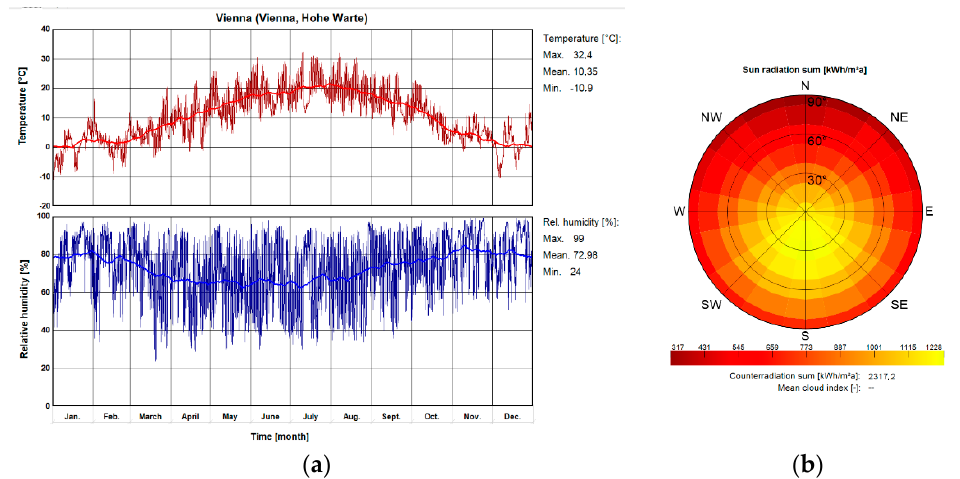
Figure 6. TRY characteristics for Vienna: ( a )—air temperature and relative humidity; ( b )—solar radiation intensity. Source: WUFIplus ® database.